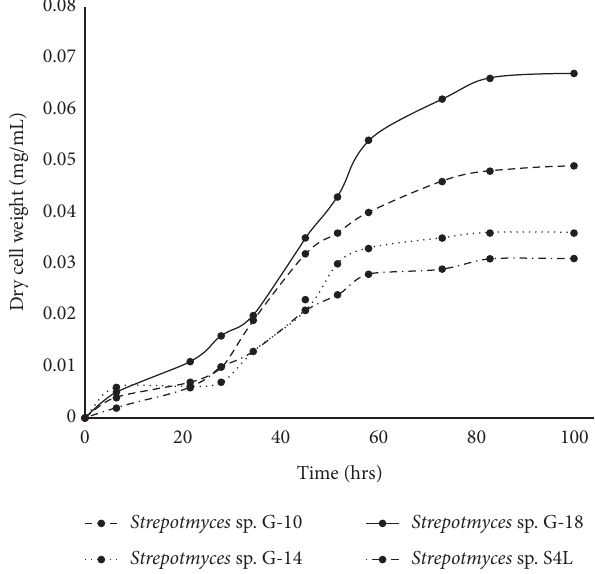
Figure 1: Growth curves of the Streptomyces species (G-10, G-14, G-18, and S4L) in the R2YE